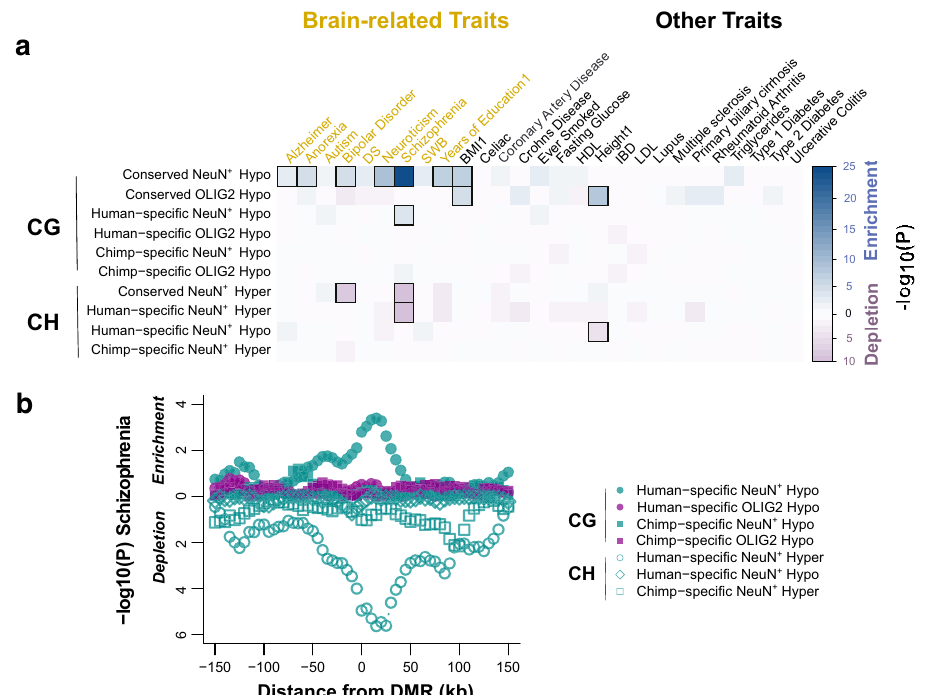
Fig. 4 Evolutionary DMRs contribute to brain disease susceptibility. a Signi fi cance levels for the enrichment for genetic heritability in different DMRs ( + /-25kb) and complex traits. Both conserved and human-speci fi c neuronal DMRs are associated with schizophrenia. Enrichment with FDR < 0.05 are highlighted in squares. Notably, CG DMRs hypomethylated in NeuN + cells compared to OLIG2 + cells in all three species (conserved NeuN + hypo) are highly enriched in variants for several brain-related traits, and human-speci fi c NeuN + hypo shows enrichment in schizophrenia. b A sliding-window analysis further demonstrates that the aforementioned signal for schizophrenia was centered at the DMRs and did not originate from extended adjacent regions. The y -axis represents the P -values in sliding windows around DMRs classi fi ed by species (human or chimpanzee), cell-type (NeuN + or OLIG2 + ), and cytosine context (mCG or mCH). Source data are provided as a Source Data fi